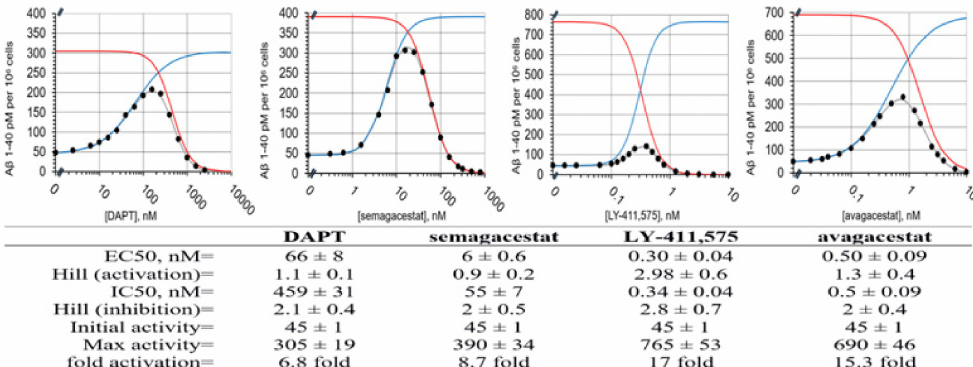
Figure 1. Dose-response curves for A β 1-40 production in SH-SY5 cells in the presence of DAPT, semagacestat, LY-411,575, and avagacestat. The A β 1-40 production in the SH-SY5 cells shows biphasic activation–inhibition dose-response curves with all four drugs ( • ). The different parameters that describe the biphasic dose-response curves were calculated and listed in the table (methods, Equation (1)) [11]. The gray lines represent the best-fit curve to the experimental values ( • ). The blue and red lines represent calculated activation and inhibition events if the two events can be separated (methods, Equation (1)). The activation constants (EC50) and the inhibition constant (IC50) represent the affinity for each binding event. The Hill’s coefficients represent the stoichiometry of the interaction, and/or possible cooperative processes in the binding events. The ‘Max activity’ parameter represents the maximal possible activation if there is no competing inhibition. The ‘Max activity’ parameter correlates with the ability of drugs to facilitate enzyme–substrate interactions [11]. The initial activity is the same for all four drugs, because all of the measurements used the same batch of